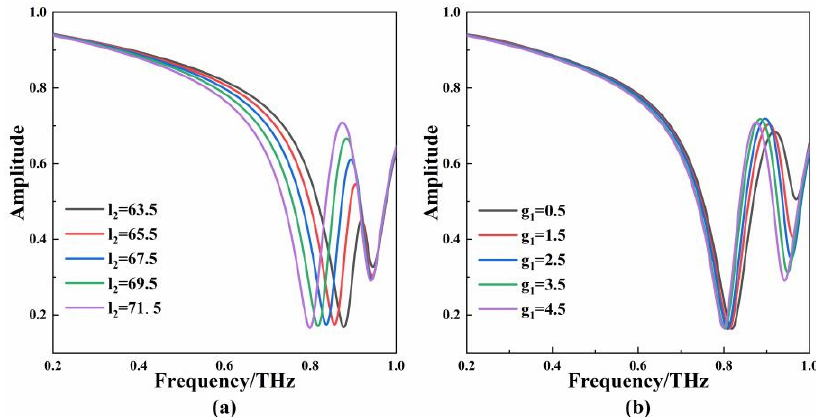
Figure 5. ( a ) The transmission curves corresponding to different lengths of l 2 ; ( b ) the transmission curves corresponding to different lengths of g